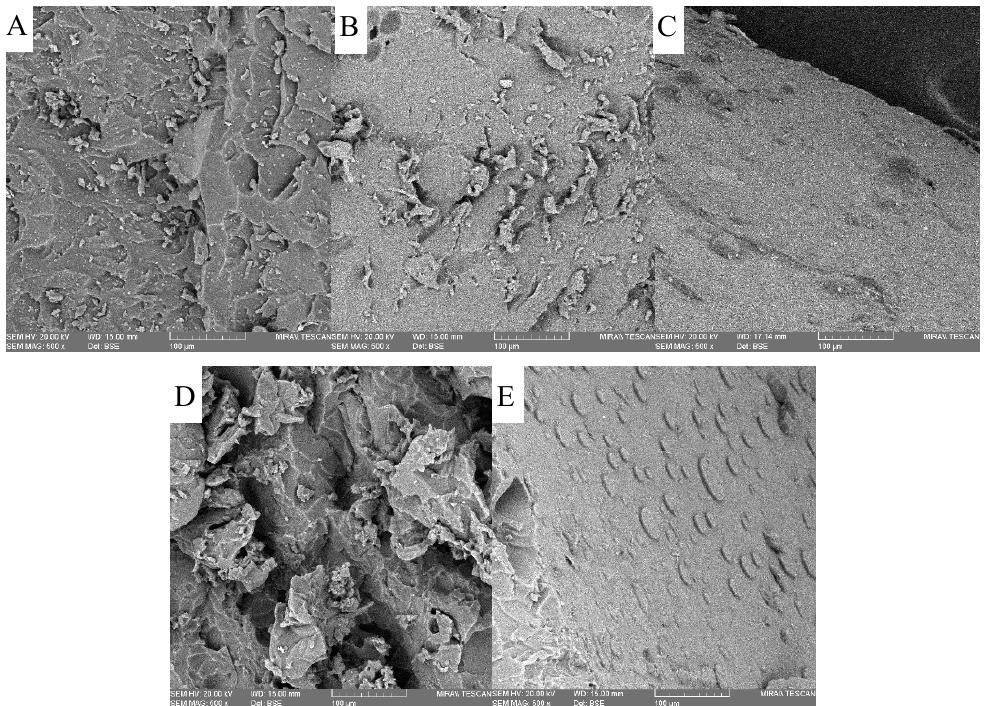
Figure 7. Scanning electron microscopy images of the surface topography of PEGDMA and PEGDMA-thiol hydrogels; ( A ) PEGDMA ( B ) DiPETMP, ( C ) PETMP, ( D ) GDMP and ( E ) ETTMP 1300.